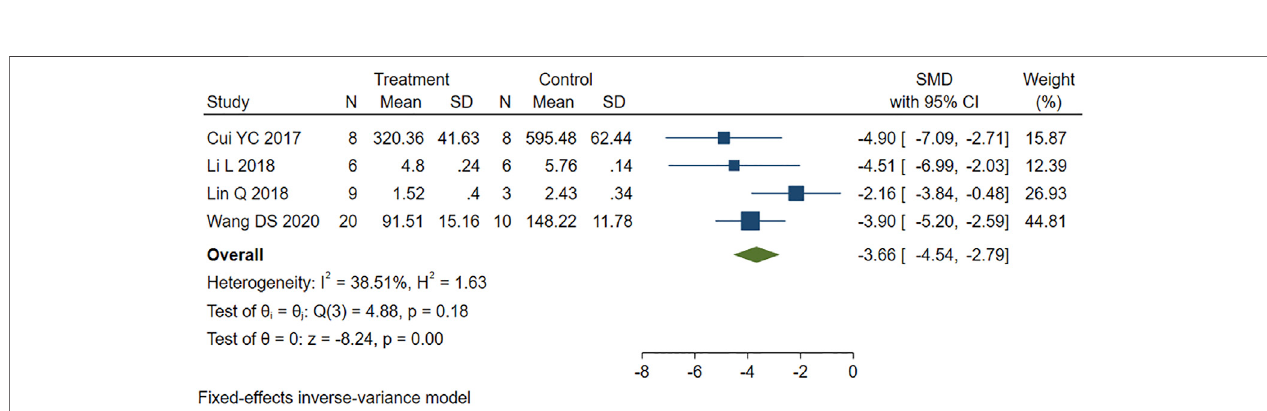
FIGURE4| ForestplottostudytheeffectofPEoncardiactroponinI(cTnI).PEreducedserumcTnIlevelsinMIRIanimalscomparedtocontrolgroup(SMD= − 3.66, 95%CI: − 4.54to − 2.79, p < 0.001).Thedarksquaresrepresentthestandardizedmeandifference(SMD)foreachstudy.ThediamondsrepresentthepooledSMD.95% of the CIs are indicated by lines. The analysis was conducted using a fi xed-effects model.